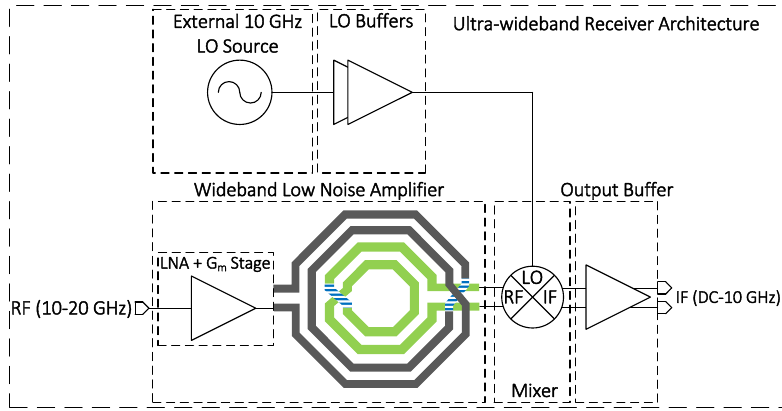
Figure 1. Proposed receiver